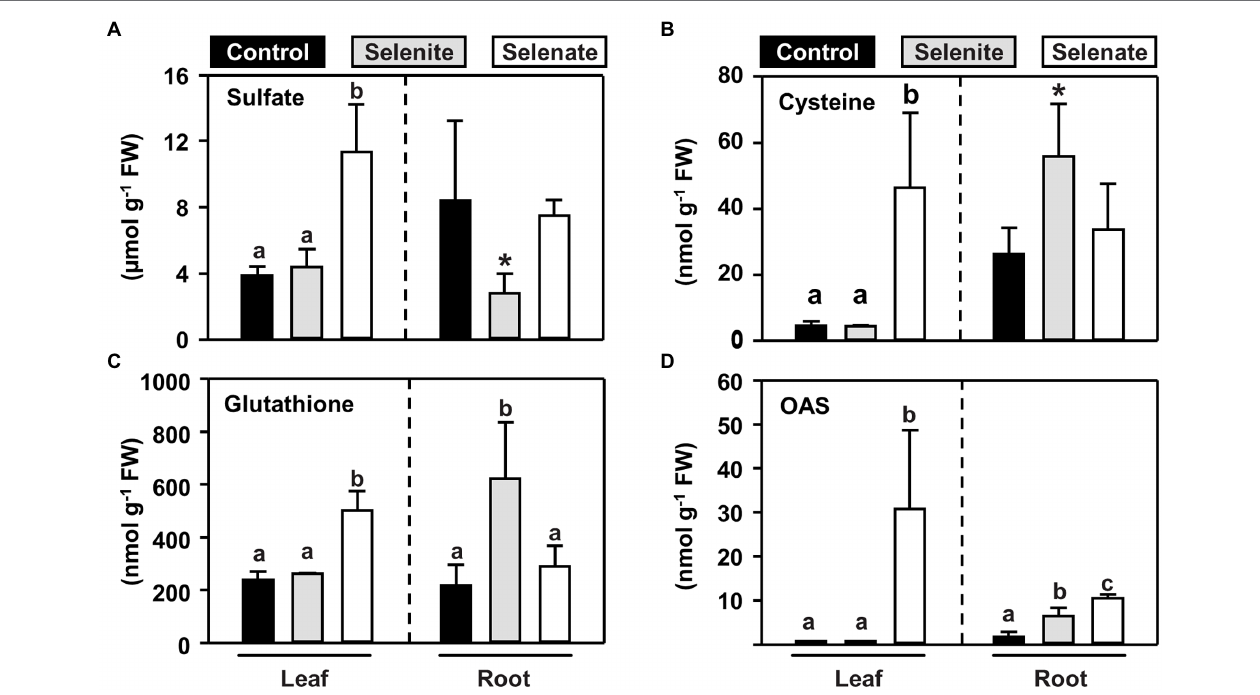
FIGURE 3 | Organ-specific impact of selenite and selenate application on key metabolites of the reductive sulfur assimilation pathways. (A–D) Steady-state levels of sulfate (A) , cysteine (B) , glutathione (C) and the carbon-nitrogen backbone for sulfide/selenide incorporation, OAS (D) in leaves and roots of seven-weeks-old hydroponically grown Arabidopsis plants challenged for one week with 50 μ M selenite (gray), 50 μ M selenate (white) or no additional selenium (control, black). Different lowercase letters indicate individual groups identified by pairwise multiple comparisons with a Holm-Sidak one-way ANOVA (P, 0.05, n = 7). If the power of the α -test was too low in the one-way ANOVA, we tested the statistical difference between control and the single selenium treatment by a paired students t-test (* p = <0.05). FW, fresh